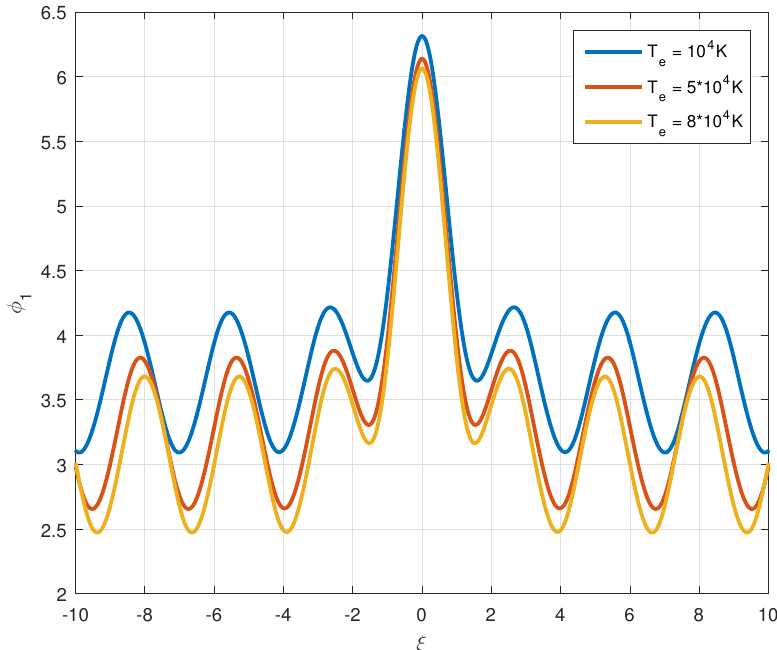
Figure 9. This is the form of quasi-soliton or the nanopteron soliton for which its analytical form is given by